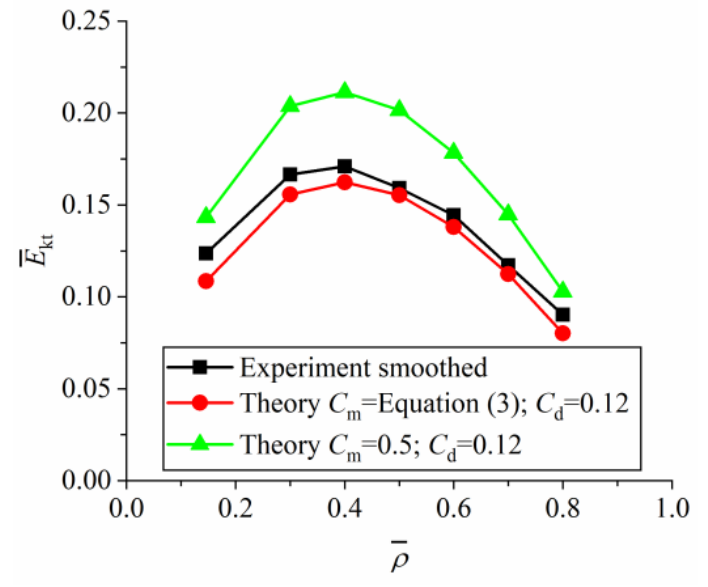
Figure 14. Dimensionless kinetic energy E kt of the sphere just before contacting the ice plate versus the relative density obtained by three methods with h = 0.089 and L 0 = 2.31 constant.